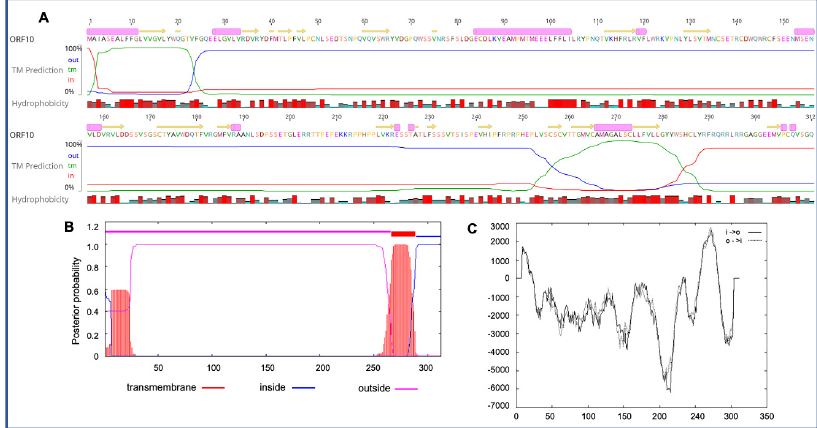
Figure 2. Predicted structure of the unique PaAdV1-ORF10. ( A ) prediction of transmembrane helices (TMHs) in unique PaAdV1-ORF10 gene using EMBOSS 6.5.7 tool in Geneious (version 10.2.2) ( A ), TMHMM ( B ), and TMpred ( C ). All the programs consistently predicted two TMHs. ( A ) TMHs detected by EMBOSS also showed the presence of alpha-helices within TMHs predicted region that has been dominated by highly hydrophobic residue (red colour). ( B , C ) The x -axis represents the position of residue, whereas y -axis represents the posterior probability ( B ), and scores (above 500 are considered significant) ( C ) for the predicted TMHs. ( C ) Solid and dashed black lines indicate protein orientation as inside to outside, and outside to inside, respectively.